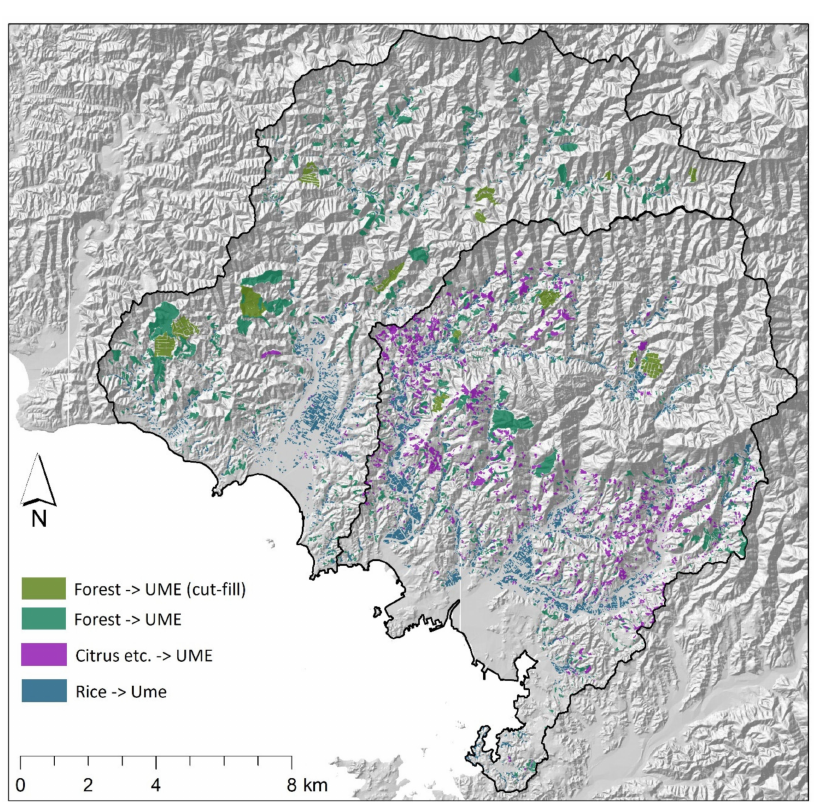
Figure 4. Map of changes in land use at the parcel level between 1974 and